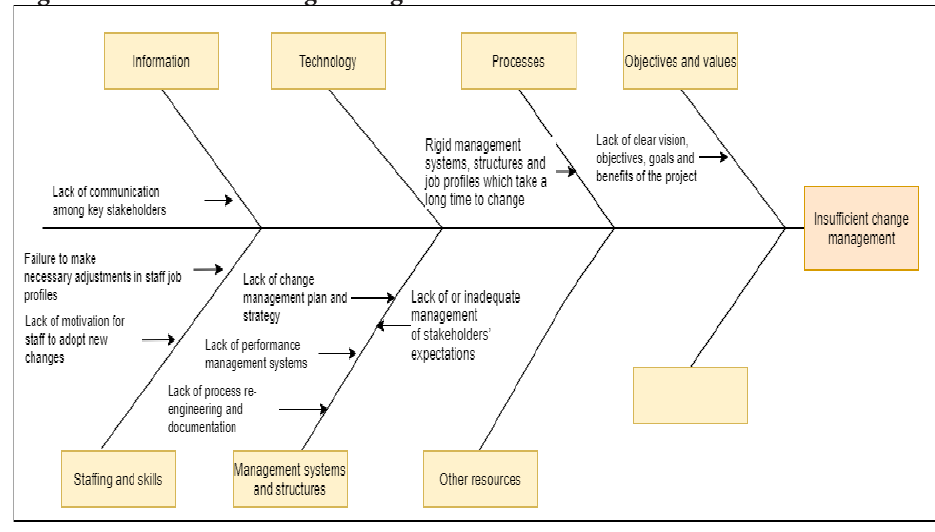
Figure 12: Insufficient change